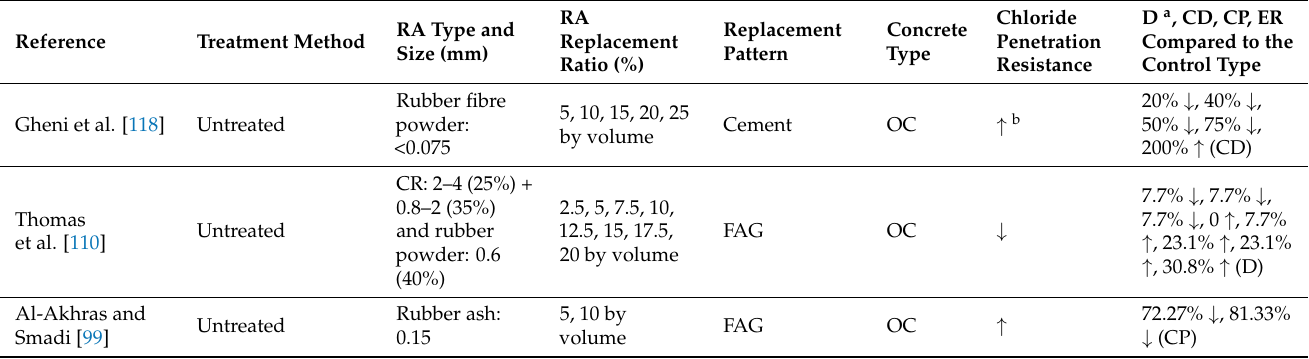
Figure 12. The condition of RA surface after two step surface treatment [122]. Table 10. Influence of rubber on the concrete chloride penetration